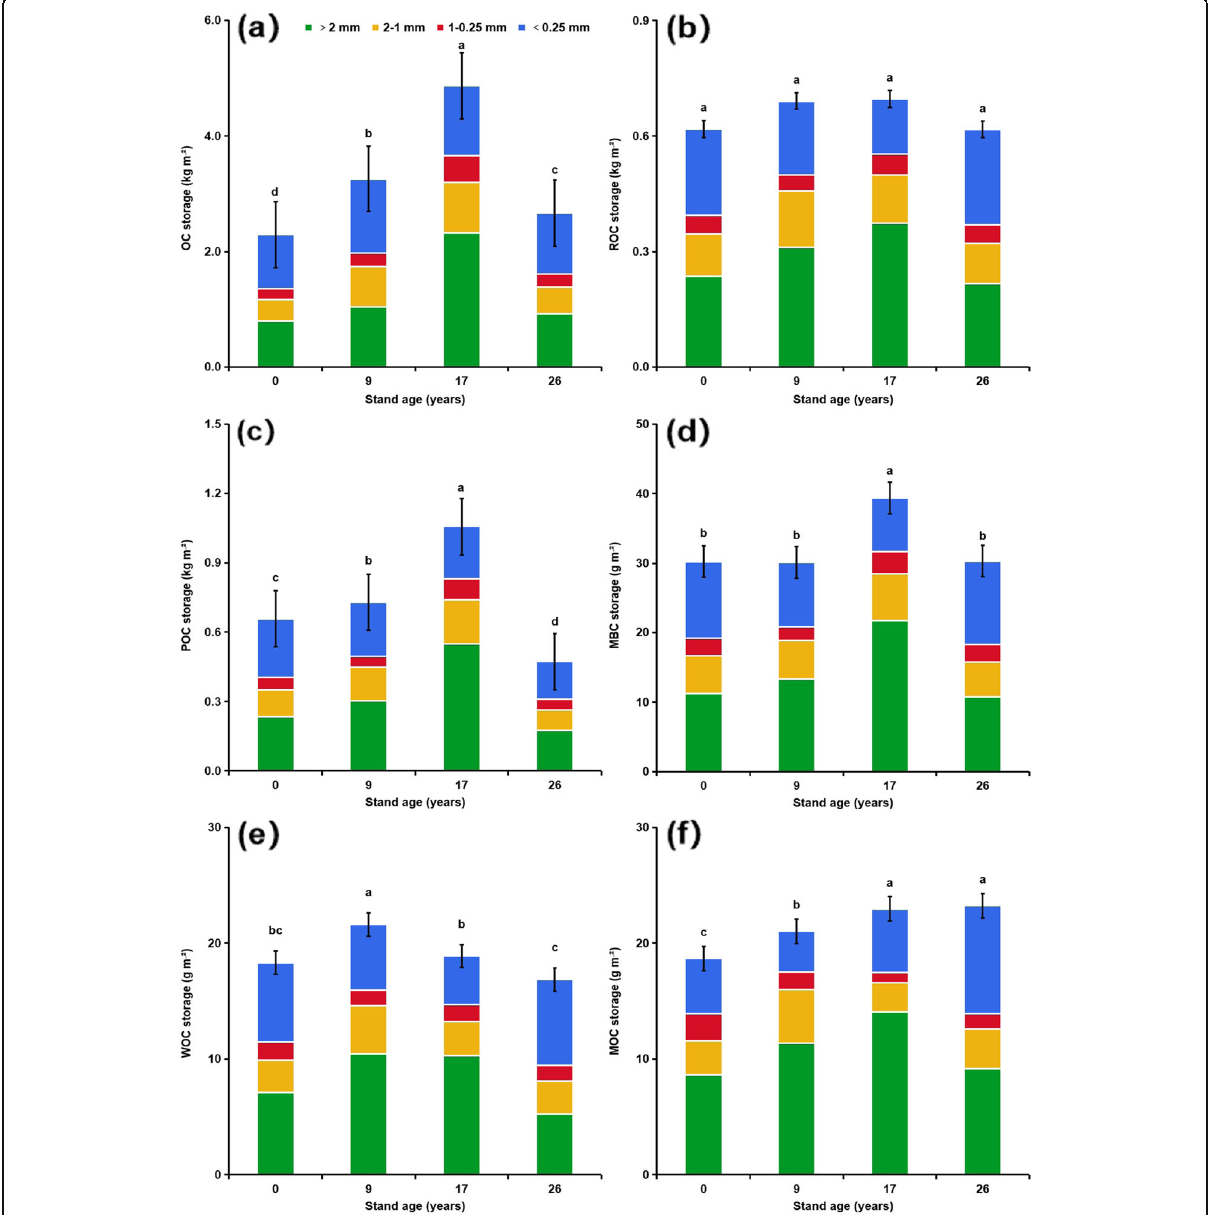
Fig. 4 Soil aggregate-related carbon storage at the 0 – 20-cm depth in the Chinese fir plantations with different stand ages (0, 9, 17, and 26 years old). Data represent the average of 3 replicates and error bars represent the standard errors. Different lowercase letters indicate significant differences among the different stand ages. OC, organic carbon; ROC, readily oxidizable carbon; POC, particulate organic carbon; MBC, microbial biomass carbon; WOC, water-soluble organic carbon; MOC, mineralized organic